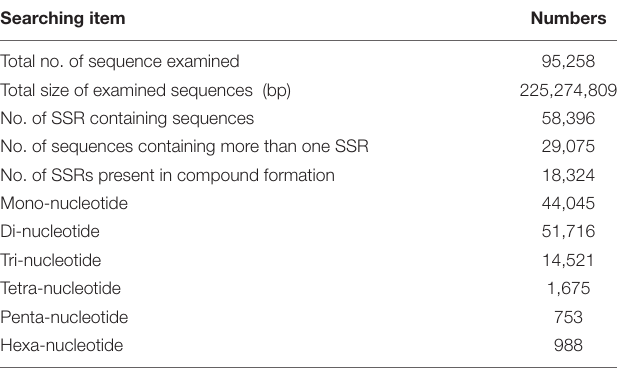
TABLE 5 | Summary of SSR identified in Schima superba.